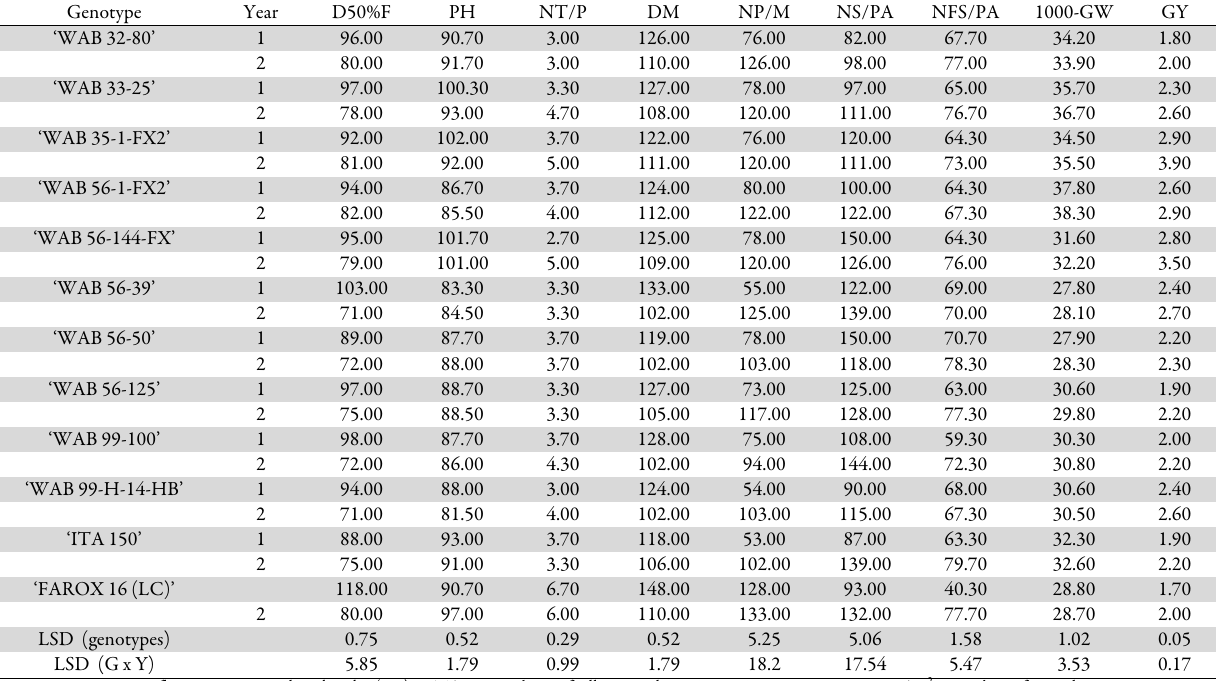
Table 2. Agronomic traits performance of the 12 rice genotypes across the two years Genotype